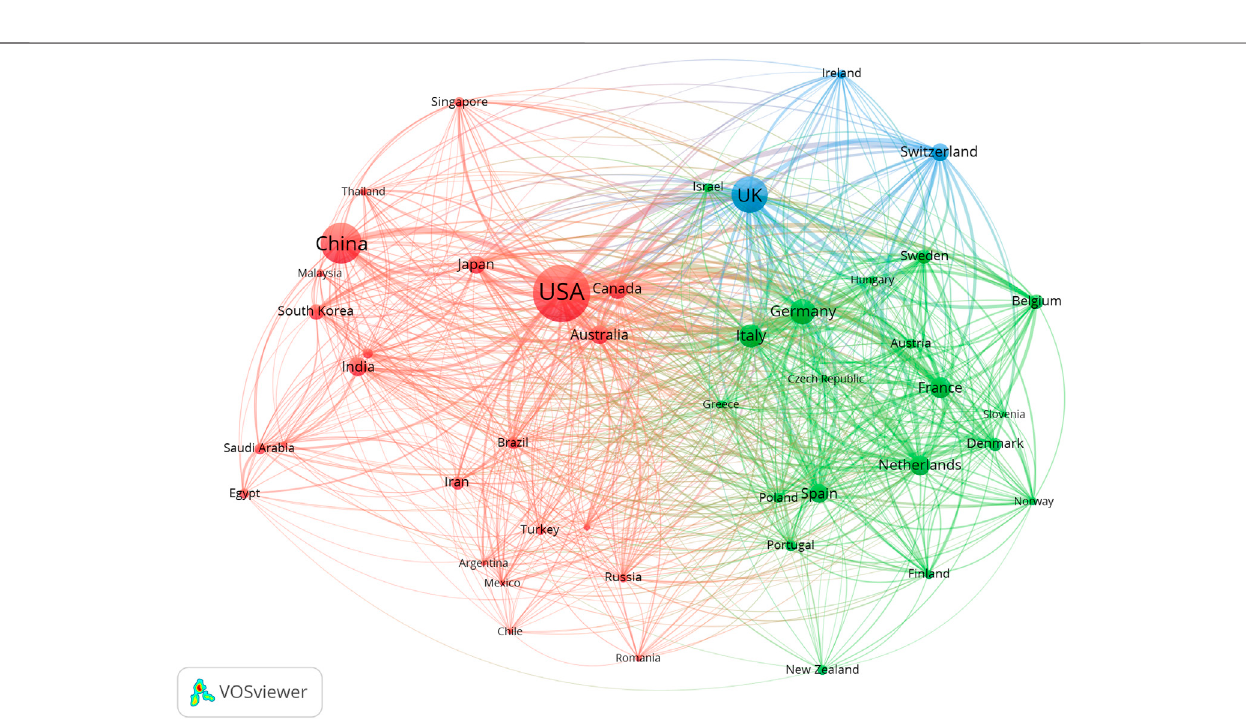
FIGURE 4 | Map of collaborative networks among a country of high-impact papers in pharmacology and pharmacy research around the world.